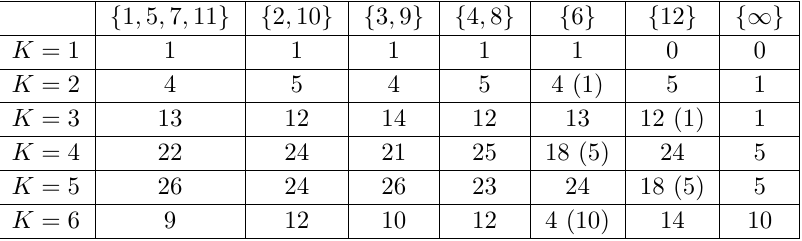
Table 9 . Number of Bethe roots for decomposed BAE with M =